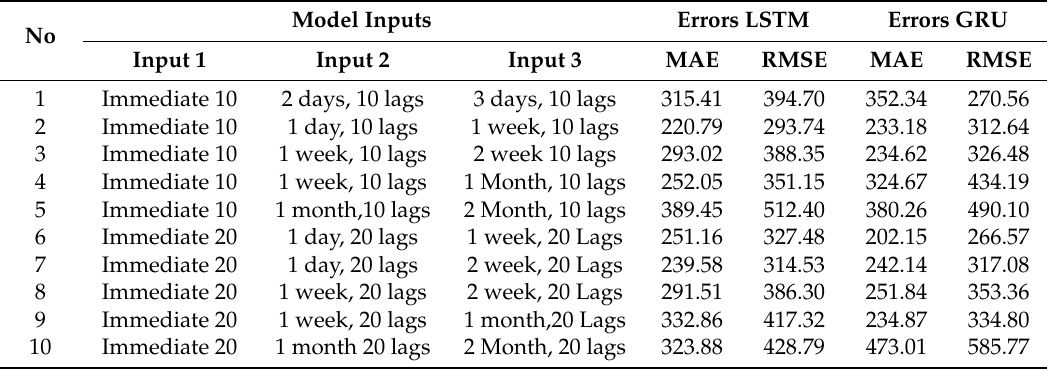
Table 4. Impact of the Different timescales on LSTM and GRU models performance.